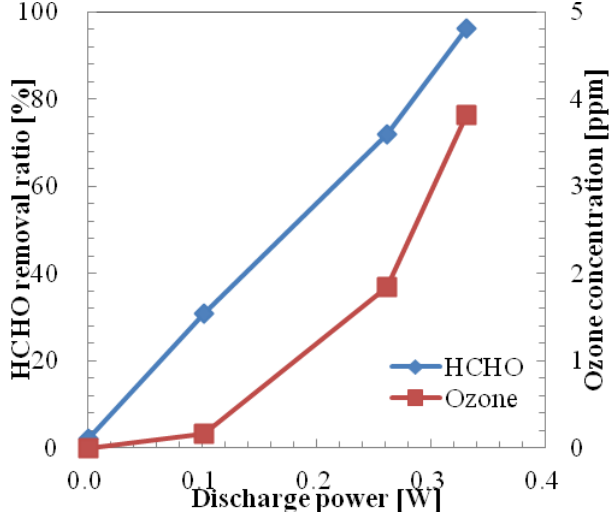
Figure 9. HCHO and O concentration in one pass treatment by Marx 3